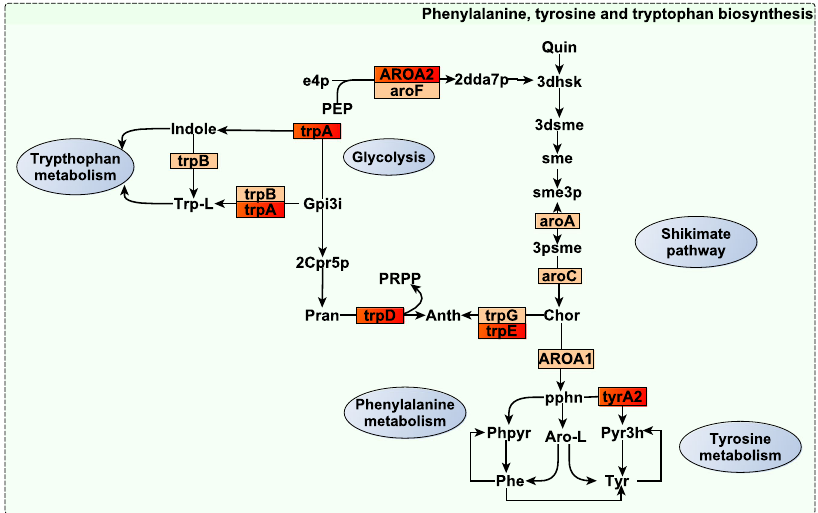
Fig. 4 Reaction scheme of phenylalanine, tyrosine and tryptophan biosynthesis in which additive log-ratio transformed microbial gene abundances strongly host genomically correlated with methane emissions ( r gCH4 ) are involved. Small rectangles symbolize proteins encoded by the microbial genes. Microbial genes are highlighted in red when their r gCH4 estimates range between − 0.74 and − 0.93 and show a probability of being different from 0 ( P 0 ) ≥ 0.95, and in orange when they range between |0.55| and |0.77| and P 0 ≥ 0.85. Compounds are denoted by their short names. Source data is in Supplementary Data 9. Full names of compounds and microbial genes are given in Supplementary Data